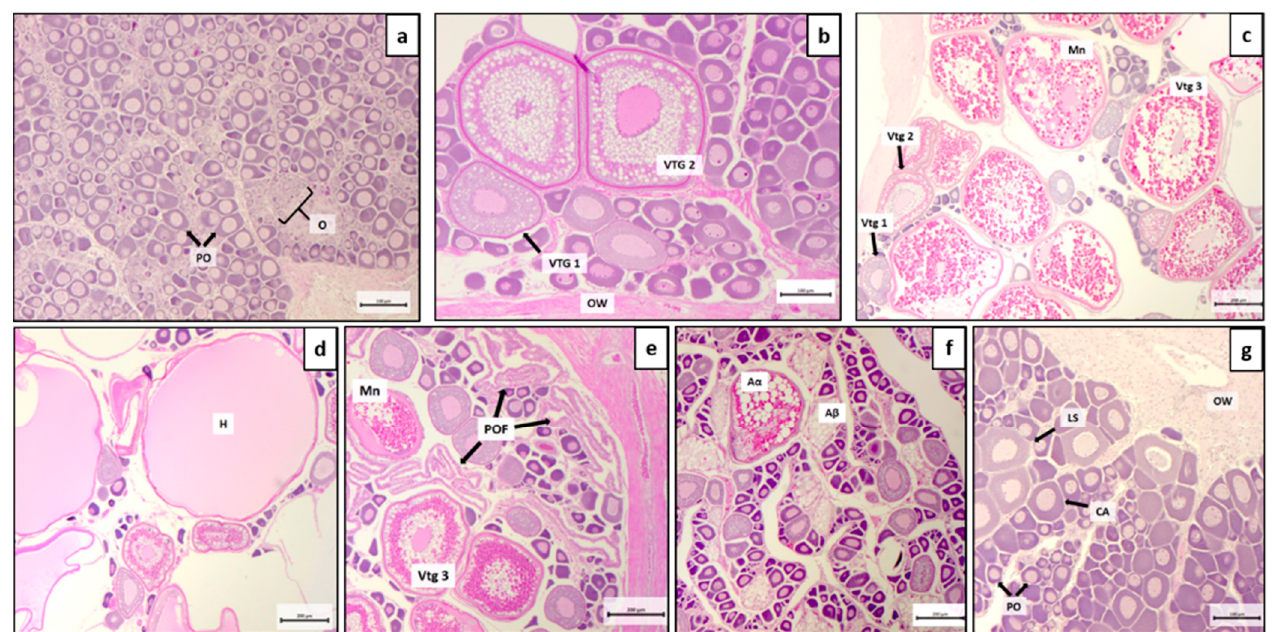
Figure 6. Tissue sections of European hake ovaries at different developmental stages. ( a ) Immature; ( b ) developing; ( c ) spawning capable; ( d , e ) actively spawning; ( f ) regressing; ( g ) regenerating. For a,b,g scale bar = 100 μ m; for c,d,e,f scale bar = 200 μ m. The abbreviations indicate: OW, ovarian wall; O, oogonia; PO, primary oocytes; CA, cortical alveoli; LS, lipid stage; vtg1, vitellogenesis 1; vtg2, vitellogenesis 2; vtg3, vitellogenesis 3; Mn, migrating nucleus; H, hydrated oocytes; POF (postovulatory follicle); A α , alpha atretic oocyte; A β , beta atretic oocyte.